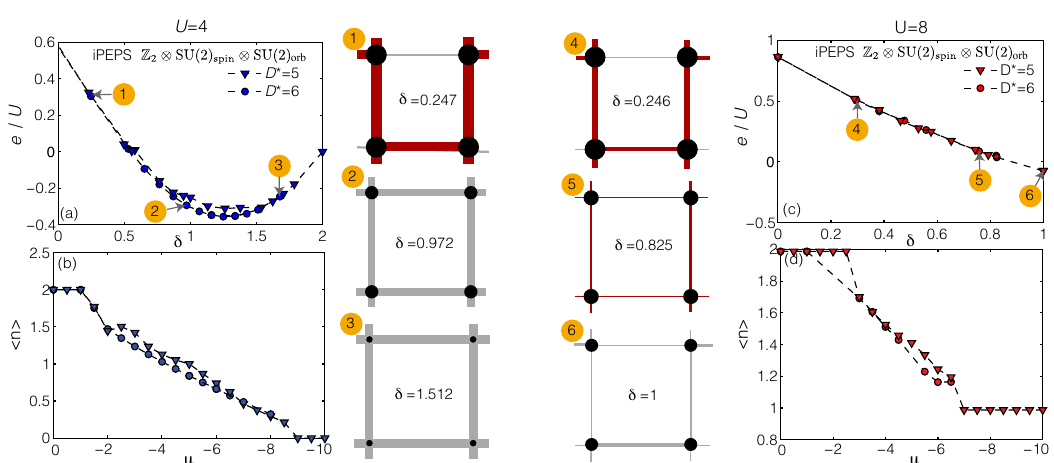
Figure 9: Non-abelian iPEPS results for the two-band Hubbard model away from half filling for U = 4 (left panels) and U = 8 (right panels). Panels (a) and (c) display the / U as a function of doping δ for multiplet bond normalized ground-state energy e 0 dimensions D ∗ = 5,6. (b) and (d) show the filling 〈 n 〉 as a function of the chemical potential µ . (In contrast to Figs. 8(a,b), no QMC data are available for comparison here, hence no 1 / D ∗ 2 extrapolations were performed.) The parameter points (1) to (6) are analyzed in detail in the corresponding panels (1-6) in the center by char- acterizing the underlying iPEPS wave function. Again, the filling per site and the bond energy are proportional to the diameter of the black dots and the width of the bonds, where red (gray) bond correspond to positive (negative) values, respectively. The bond energies change signs at small doping, which is due to the definition of e ij in Eq. (81b), where the Coulomb interaction energy (positive) competes with the 0 kinetic energy